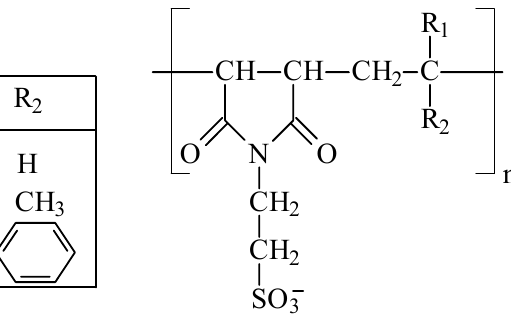
Figure 1. Structures of the polyelectrolytes: Poly(X- alt -maleimidopropyl-trimethyl- ammonium jodide) on the left side (polycation); Poly(X- alt -maleimido-ethyl (triethyl- ammonium)-sulfonate) on the right side